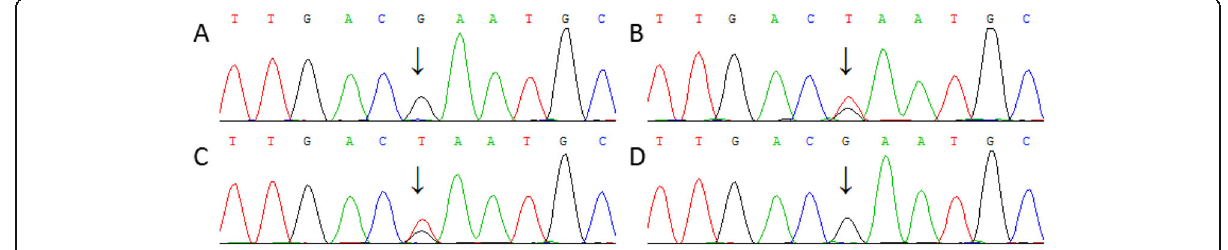
Fig. 3 Genomic Sanger sequencing results of the patient, parents, and controls. a control group; b : the patient; c the patient ’ s mother; d the patient ’ s father. The arrow indicates the c.3217 position of the FBN1